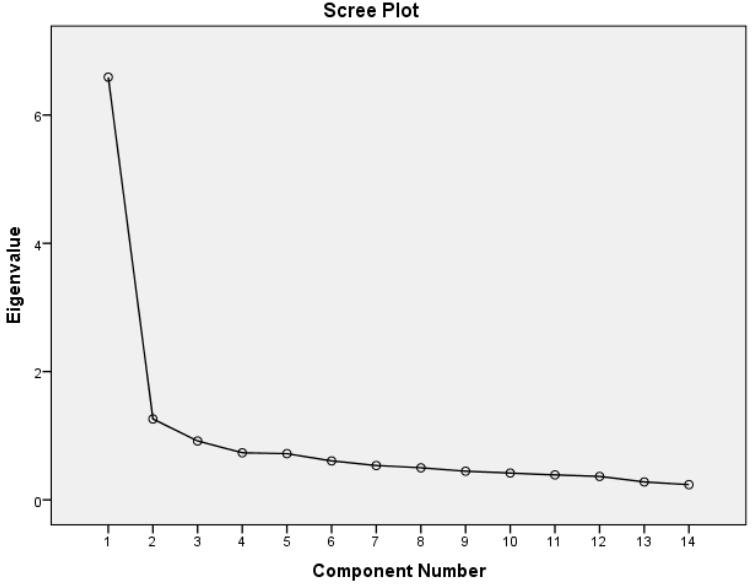
Figure 3. Sedimentation graph of the competence of Researcher Training. Source: Authors.